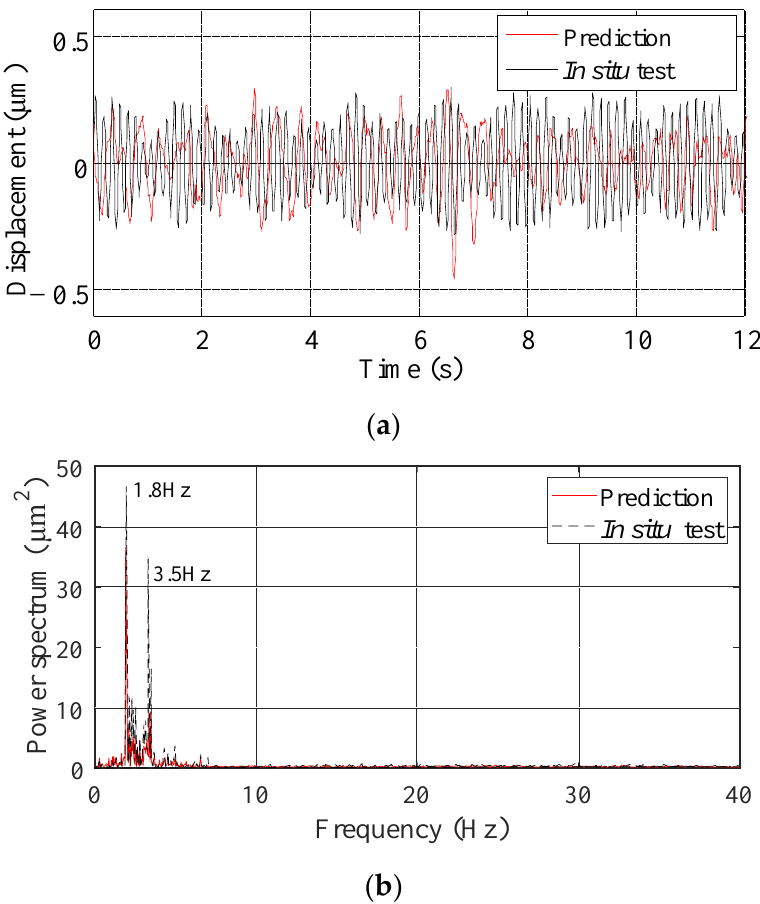
Figure 17. The signal of the prediction and the in situ measurement of signal at T9: ( a ) Time history curves; ( b ) CS.